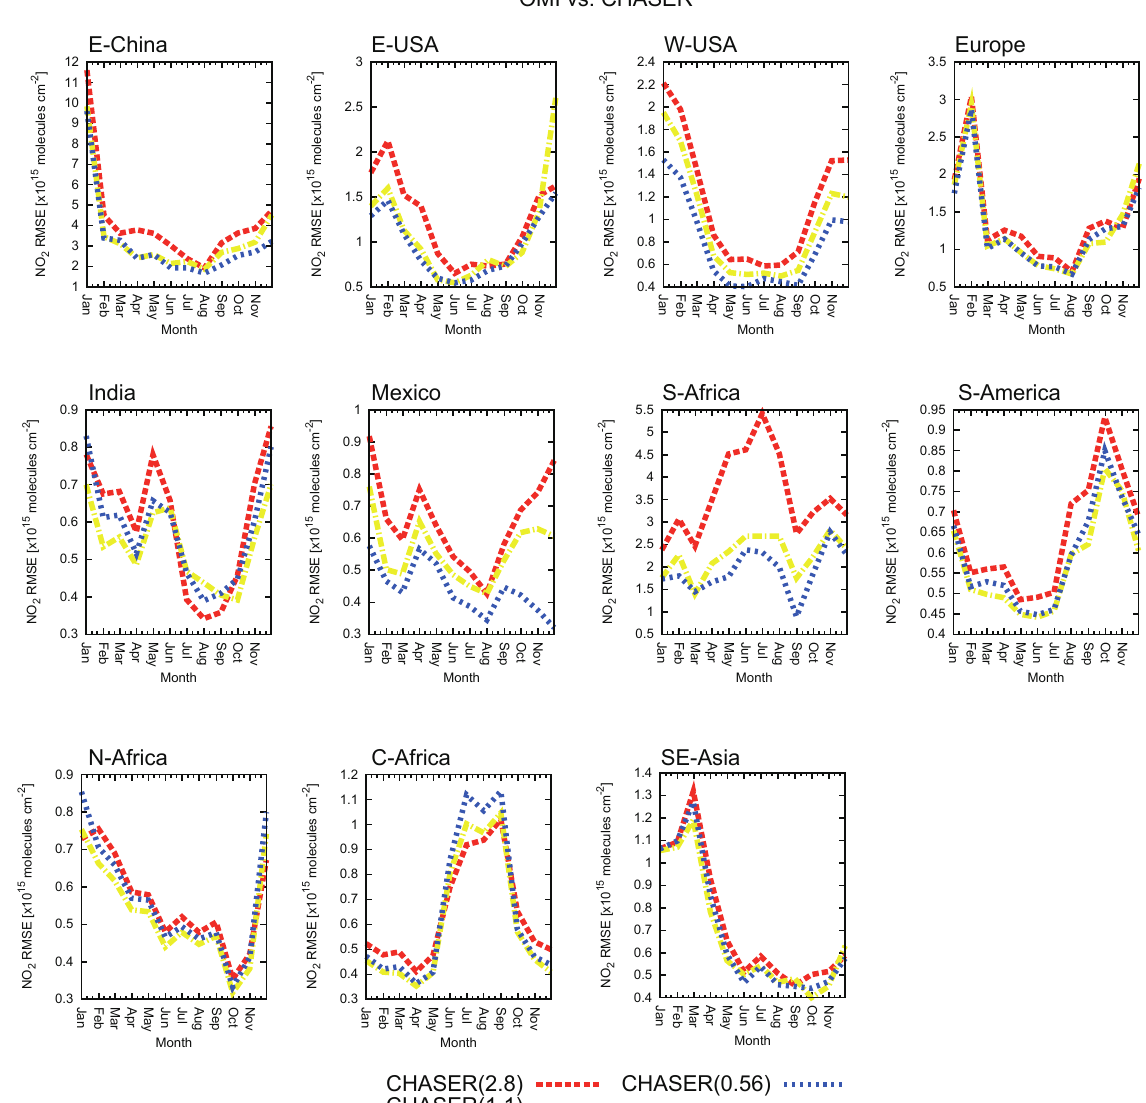
Figure 5. Same as Fig. 3, but for root mean square error (RMSE) of tropospheric NO 2 column in comparison to OMI.